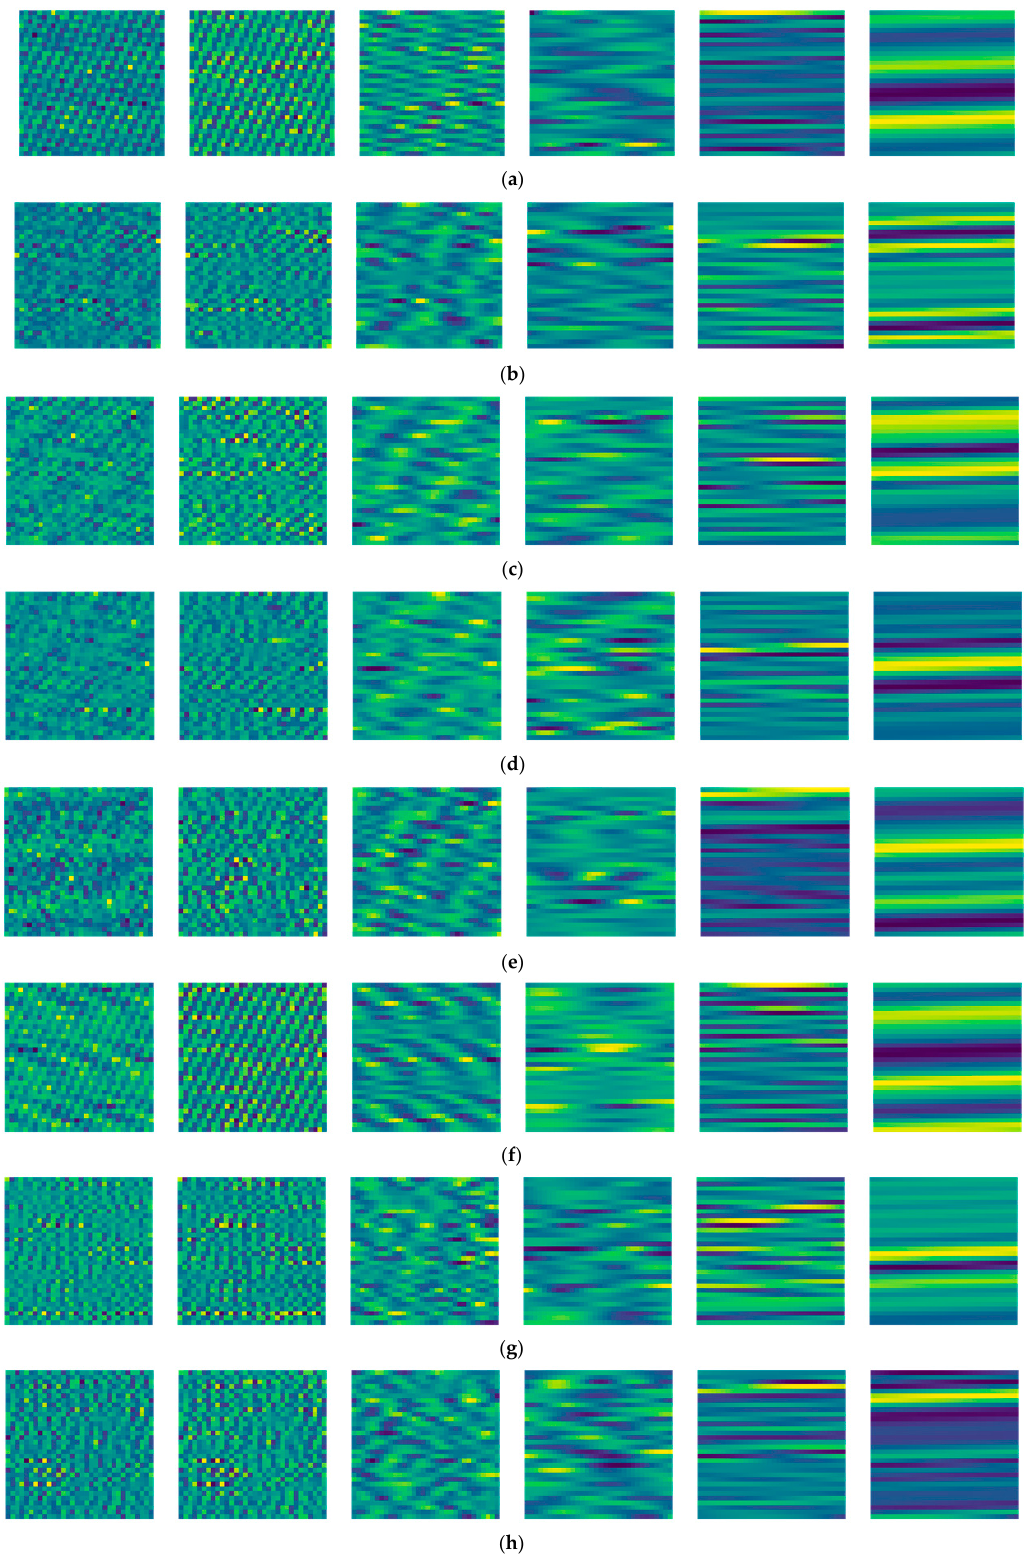
Figure 11. Two-dimensional matrix visualization of fault data. ( a ) normal; ( b ) 2 turns short circuit; ( c ) 4 turns short circuit; ( d ) 8 turns short circuit; ( e ) air gap eccentricity; ( f ) broken rotor strip; ( g ) bearing seat damage; ( h ) bearing wear.